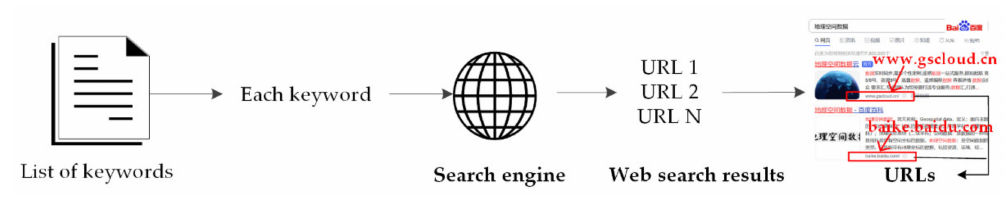
Figure 3. The basic flow of website list